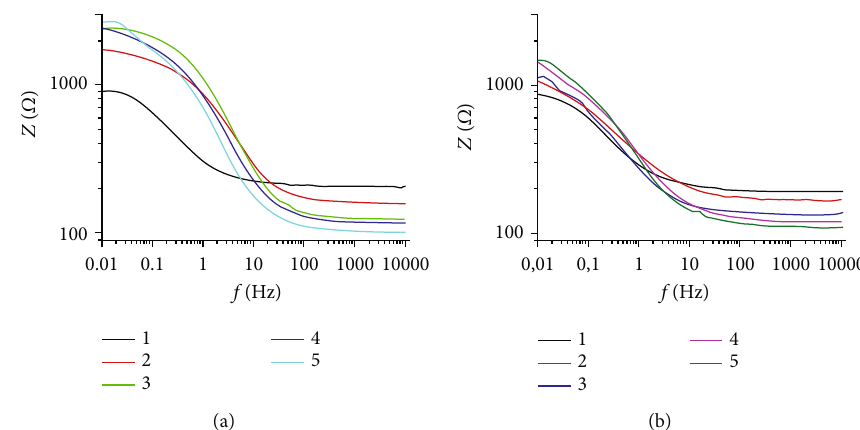
Figure 4: Frequency dependencies of impedance modulus of 09G2S steel after 3 hours (a) and 24 hours (b) of exposure to a 0.1% NaCl solution with a concentration of sodium citrate of (1) 0g/l, (2) 1.0g/l, (3) 1.5g/l, (4) 2.0g/l, and (5) 2.5g/l. Table 3: Impedance characteristics of 09G2S steel after exposure to 0.1% NaCl solution with di ff erent concentrations of sodium citrate. (ohms ⋅ cm 2 ) R s C (g/l)